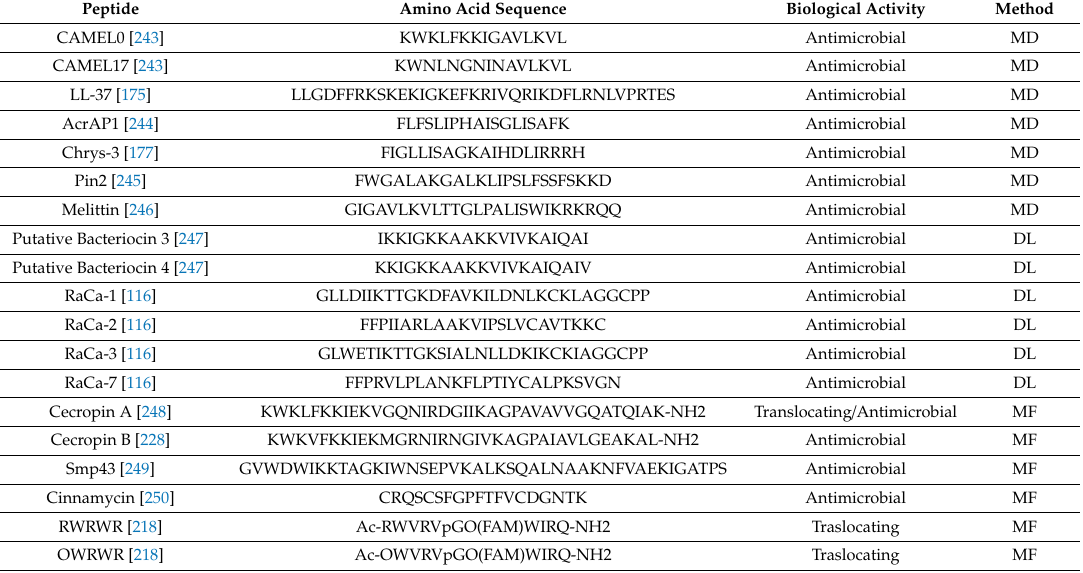
Table 1. Peptides previously designed and evaluated for their antimicrobial capacity under the mentioned methods where MD corresponds to molecular dynamics, DL to Deep Learning and MF to